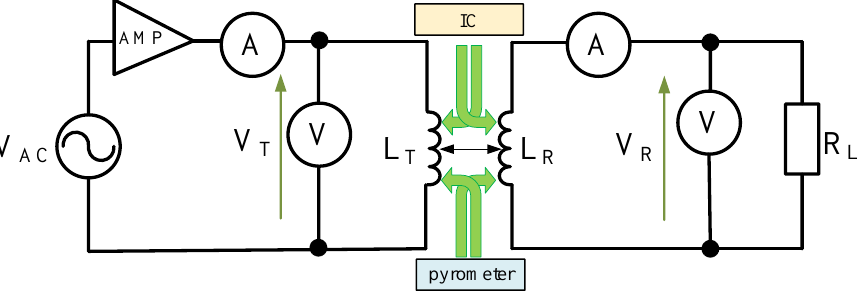
Figure 5. System for measuring the properties of an air transformer.